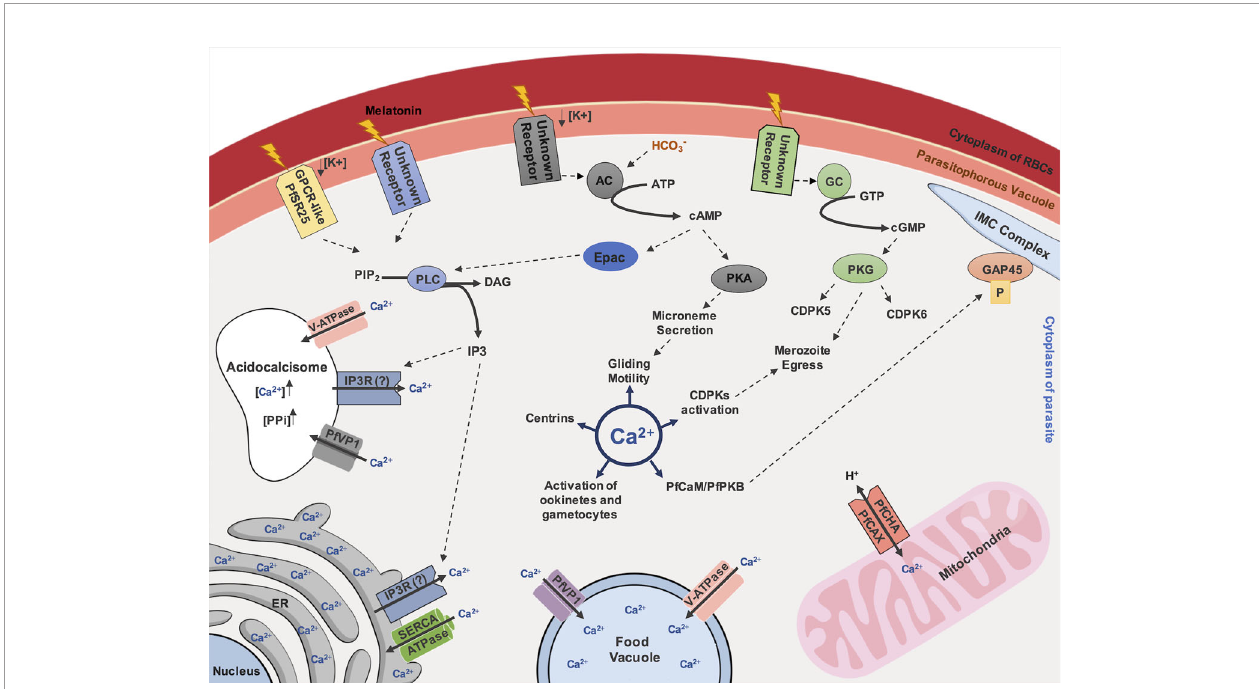
FIGURE 1 | Ca 2+ -dependent signaling pathway in Plasmodium species. Ca 2+ inside the cytoplasm of parasite controls important processes for parasite survival, such as gliding motility, mediated by activation of PfCaM/PfPKB complex and following phosphorylation of the IMC member protein, GAP45. Additionally, centrins, CDPKs activation, activation of ookinetes and gametocytes are described as Ca 2+ -regulated. A GPCR-like protein, named as PfSR25, has been described as potential regulator in Ca 2+ homeostasis in malaria parasites, depending on availability of potassium (K + ) and mediated by IP3 signaling. Melatonin was also described as a trigger for IP3 dependent pathways. Endoplasmic Reticulum (ER) is reported as the major storage of Ca 2+ and the uptake of this ion possibly depends on SERCA-type Ca 2+ -ATPases. Ca 2+ discharge depends on receptors activated by IP3, nonetheless, an IP3R remains to be discovered in Plasmodium species. The presence of V-ATPase and VP1 on the food vacuole and acidocalcisome membranes are related to the Ca 2+ uptake upon an acidic environment maintenance. Acidocalcisome could also have an IP3R that allows exit of Ca 2+ . Calcium can also enter in mitochondria through Ca 2+ /H + antiporter called PfCHA/PfCAX. Activation of PKA and PKG, by cAMP and cGMP, respectively, generated by adenylyl-cyclase (AC) and guanylyl-cyclase (GC), respectively, could also participate in Ca 2+ homeostasis, however the membrane receptors that stimulate theses pathways remains to be elucidated. Still, upon HCO 3 ¯ activation, AC can also stimulate Epac activation by cAMP, triggering IP3 signaling through PLC activation. Additionally, a cross-talk among kinases are also proposed to be associated to the merozoite egress mediated by proteolytic cascade